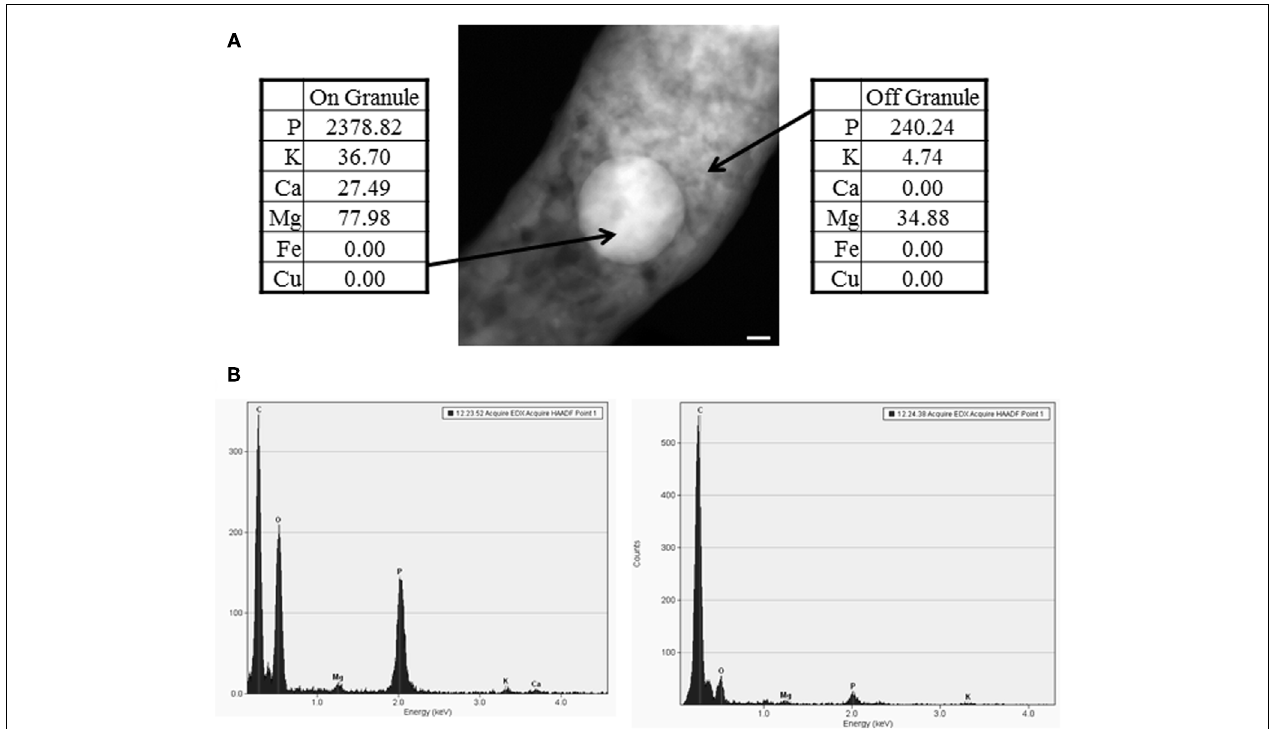
Data were collected from a minimum of two bacteria from at least two separate biological replicates, and data shown are representative. Elements presented in the spectra include C, for carbon, O, for oxygen, Ca for calcium, Na for sodium, Mg for magnesium, P for phosphorus, and K for